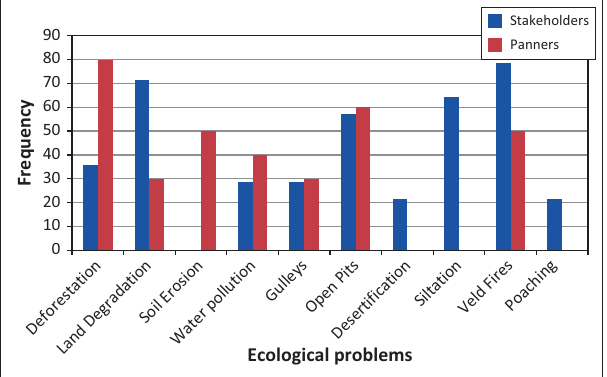
FIGURE 8: Ecological problems in Mzingwane District identified by